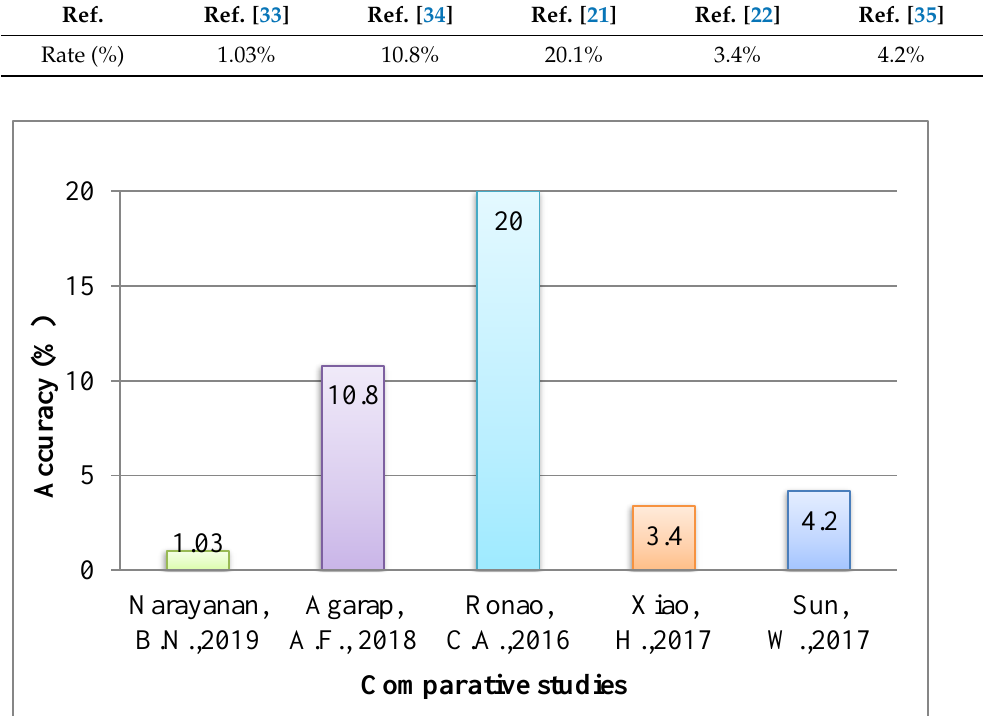
Table 9. The rate of improvement in accuracy (%).